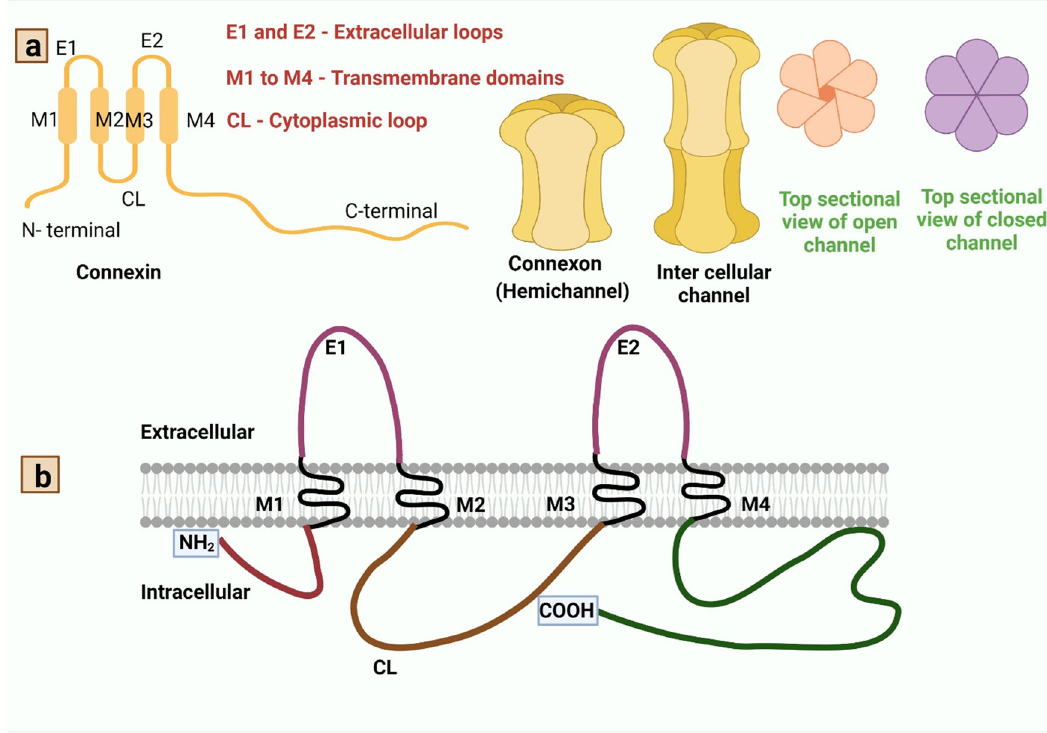
Fig. 5 Structural organization of connexins and connexons to form gap-junction. Panel a: Gap-junctions are made up of homomeric or heteromeric hexamers of connexin, connexon (hemichannels) that are situated side by side in the plasma membranes of two neighboring cells 51 . Connexins have four strongly organized transmembrane segments (TMSs), with predominantly unstructured C and N cytosolic termini, a cytoplasmic loop (CL), and two extracellular loops (EL-1) and (EL-2). Connexins create hemichannels, or connexons, within clusters of six, and two hemichannels join to produce gap-junctions. Panel b: The connexin polypeptide crosses across the membranes four times (black), exposing its amino-terminal and carboxy-terminal regions to the cytosol and connecting via two extracellular and one intracellularly exposed loops 208 . The extremely consistent amino-terminal domain (maroon) regulates its channeling pore whereas the two invariant disul fi de-linked external loops (magenta) regulate hemichannel coupling among neighboring channels 209 . The length of the cytoplasmic loop (brown) differs widely amongst connexin subclasses 210 . Within the connexin familial member, the span of the cytoplasm terminal (deep green) and its amino acid composition are highly variable 211